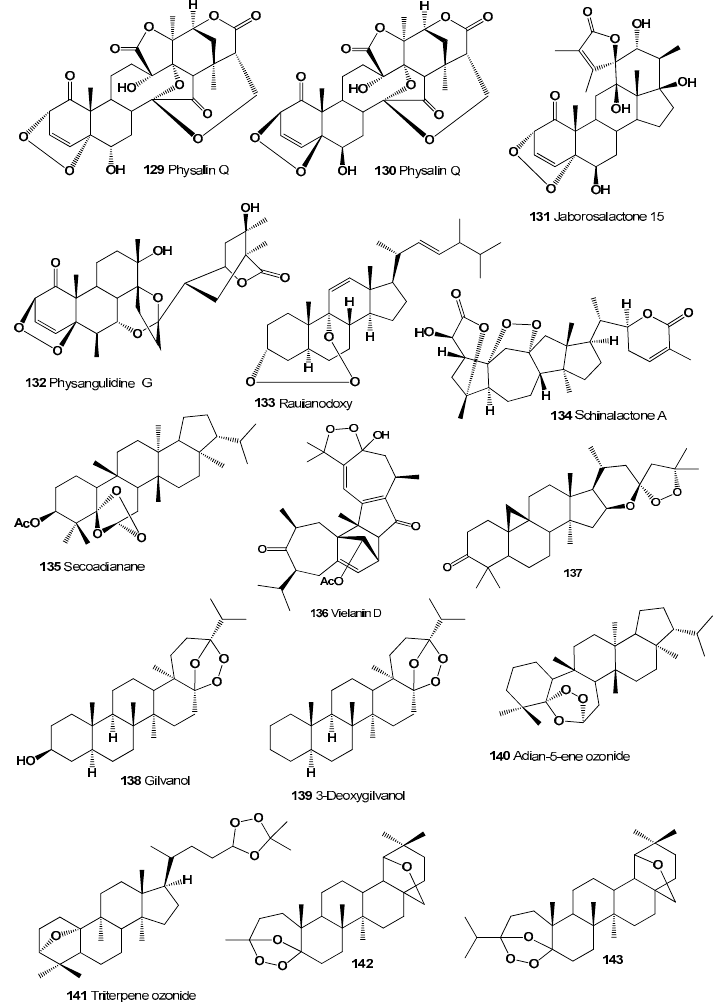
Figure 8. Bioactive polycyclic endoperoxides derived from plants.